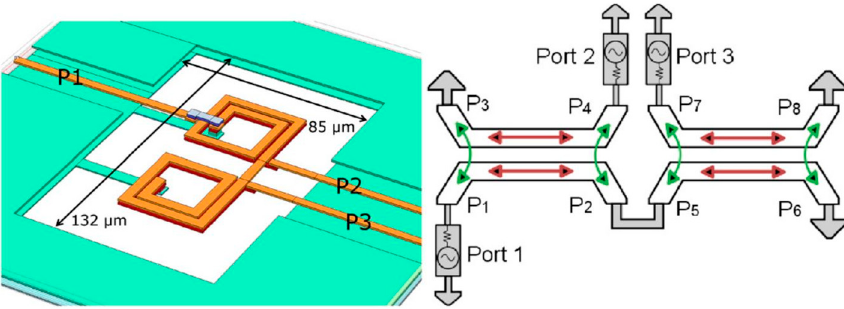
Figure 8. 3D layout of on-chip transformer balun with two distinct single-ended secondary windings, reprinted with permission from [13].